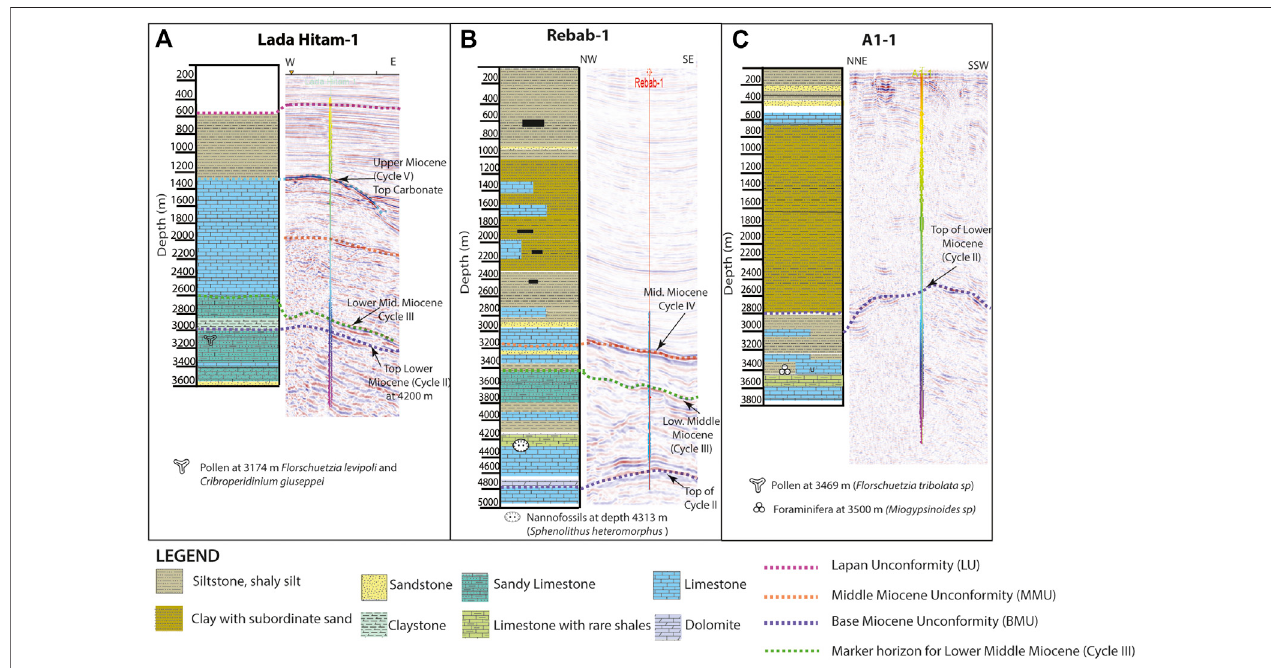
FIGURE10| Correlationoflithologicalinterpretation(fromthecoreandcuttings)andseismicinterpretationof (A) LadaHitam-1well; (B) Rebab-1well;and (C) A1-1 well. Pollen and nannofossils found in the rock samples are annotated in the lithological logs, giving more con fi dence in the age control.